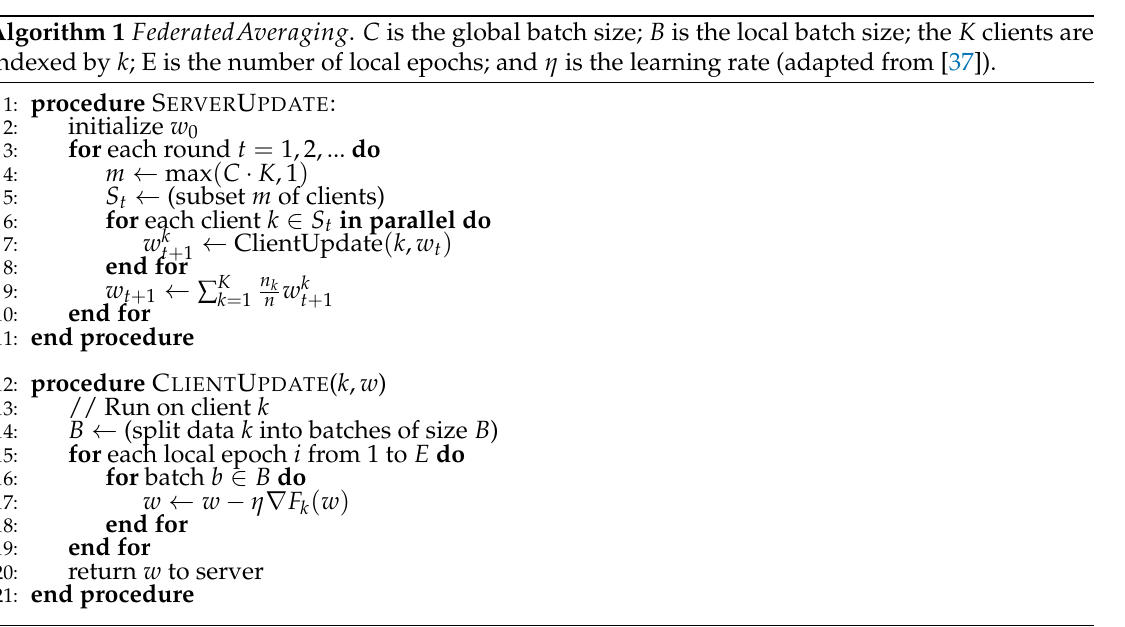
Figure 3. Centralized versus federated learning (local optimization and sharing of new weights with parameter